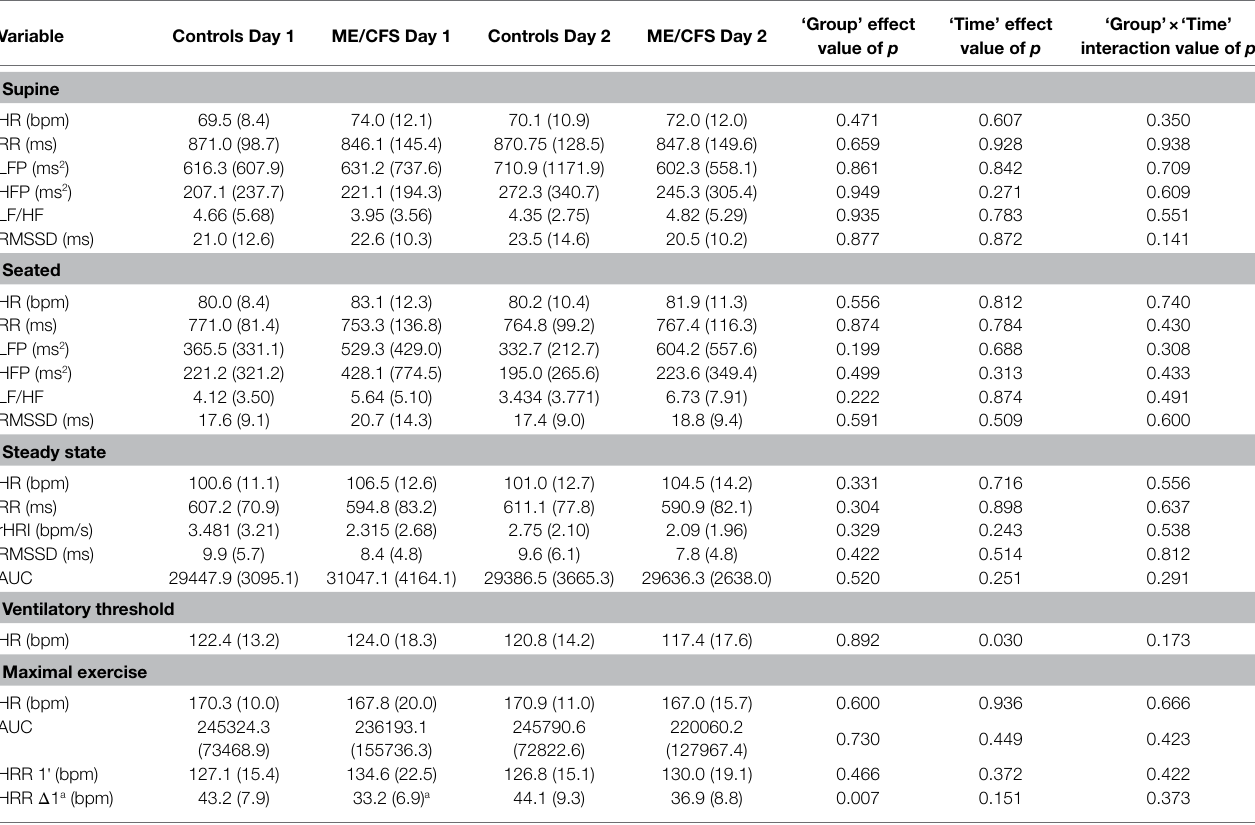
TABLE 1 | Heart rate parameters obtained during consecutive days of maximal exercise